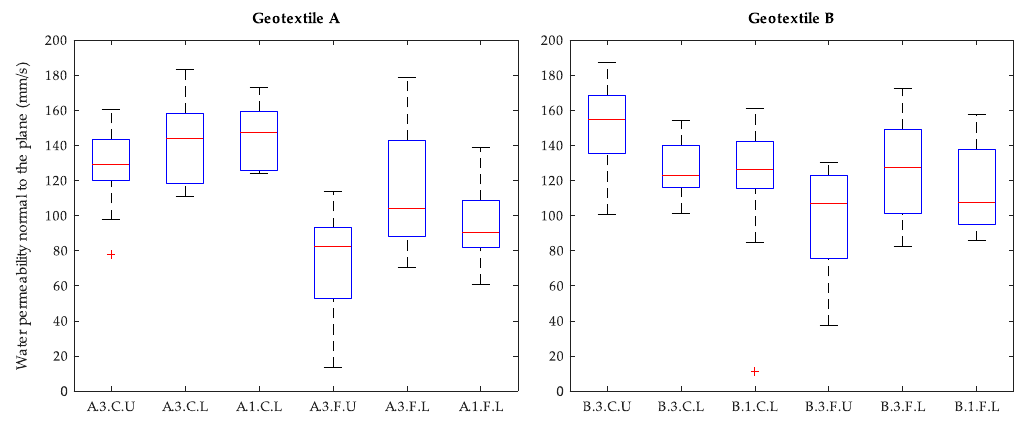
Figure 12. Box plots of the water permeability normal to the plane for every test case.